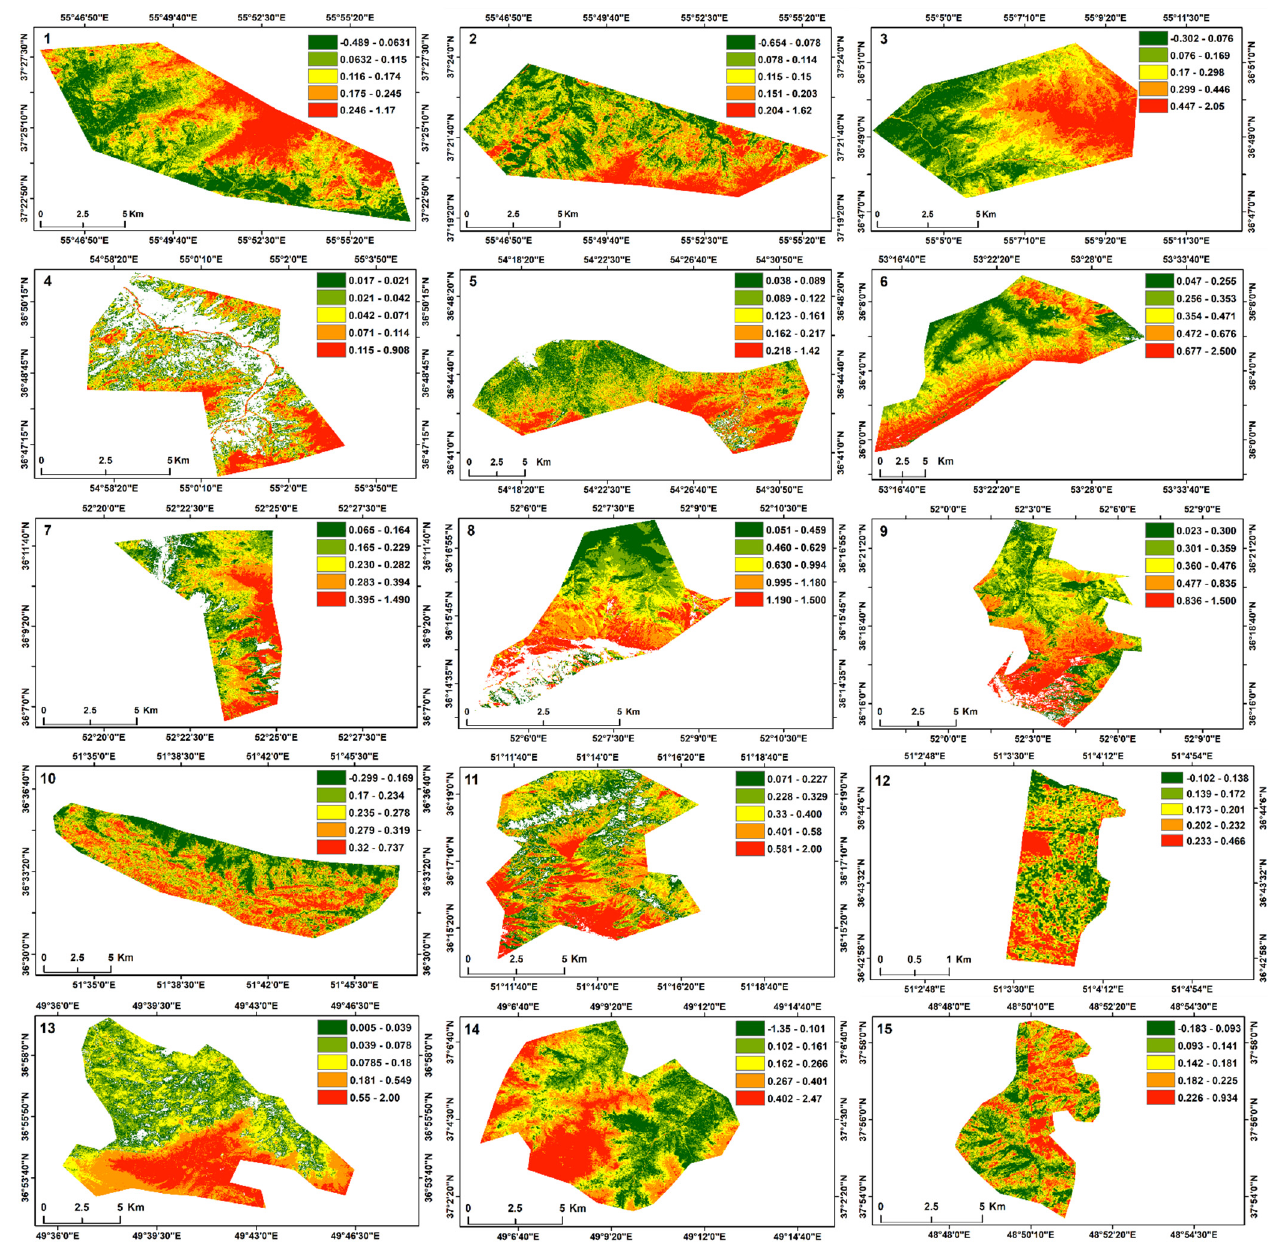
Figure 6. Sentinel-2-derived TNPI Growth maps of 15 forest sites. Site numbering from 1 to 15 corresponds to Figure 1 description of each World Heritage Site.